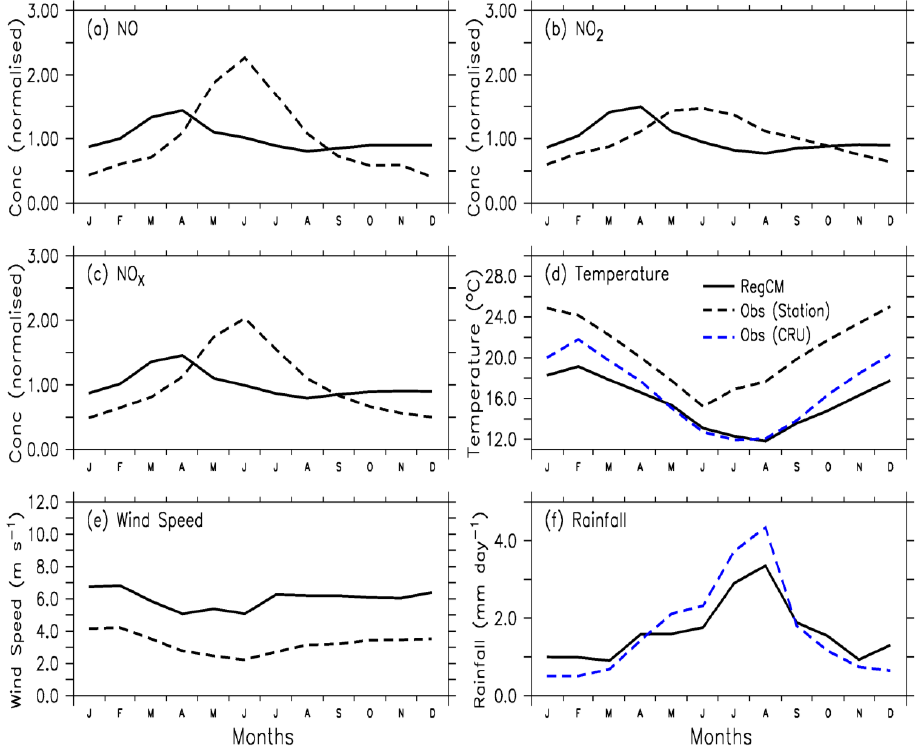
Figure 7: Seasonal variation of observed and simulated (a) NO, (b) NO 2 , (c) NO x , (d) Temperature ( o C), (e) Wind Speed (m s -1 ), and (f) Rainfall (mm day -1 ). The NO, NO 2 and NO x concentration are normalised with their annual mean values. The average observation over the four stations is indicated as Obs (station).